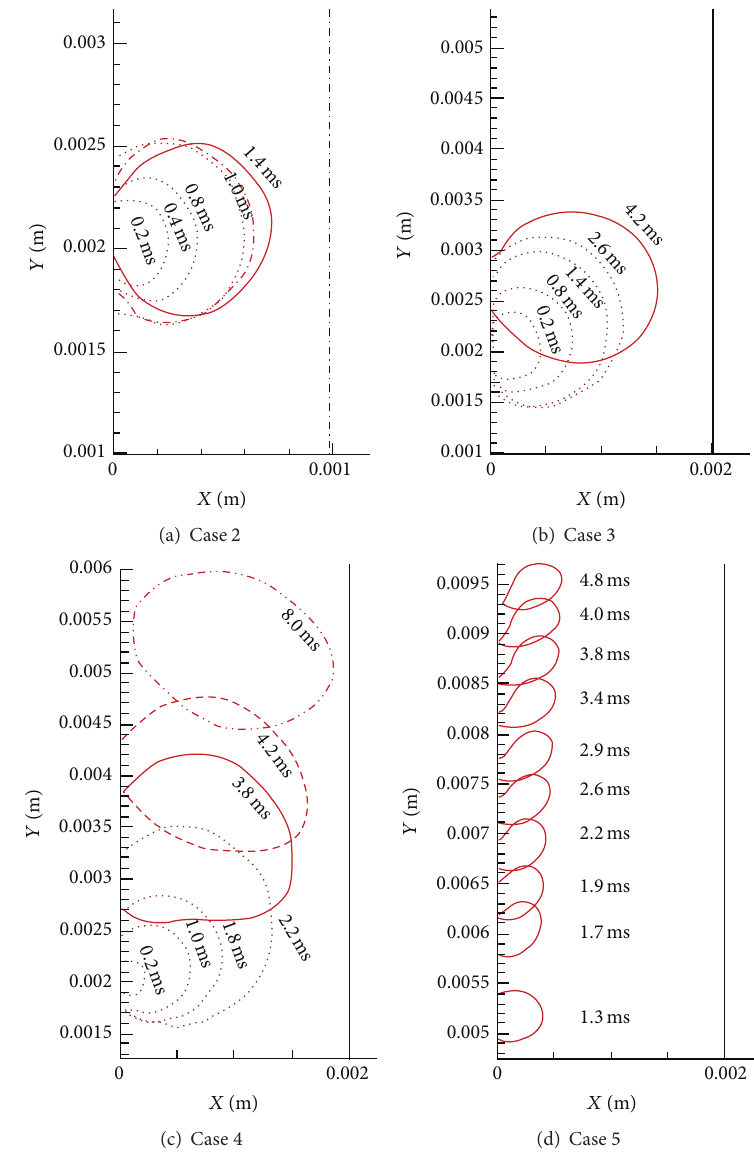
Figure 11: The evolution of bubble shape from bubble growth to movement on different